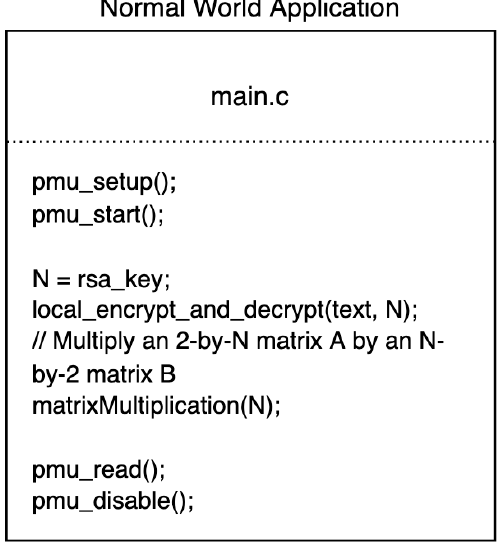
Figure 3. The code applied to the training